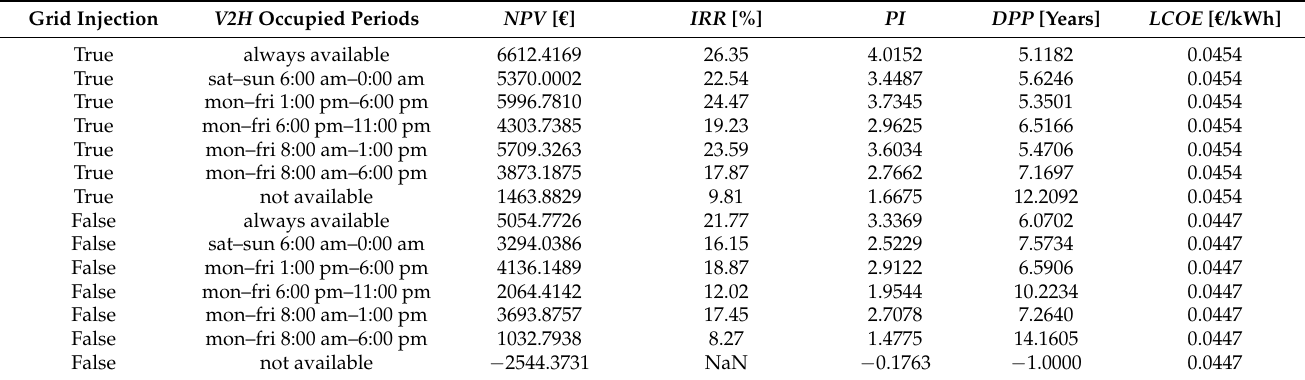
Table 8. Economical results for 3.45 kWp PV